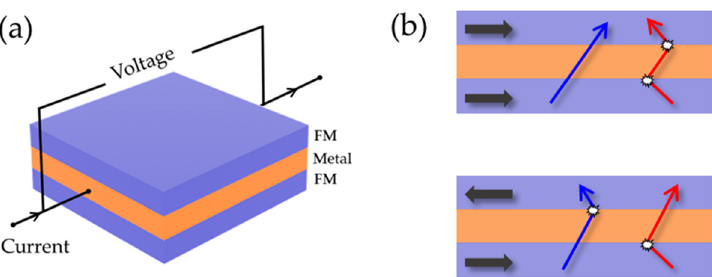
Figure 5. ( a ) Schematic representation of the GMR element, where current is flowing parallel to the film. ( b ) Schematic illustration of the two current models of GMR effect, explaining spin-dependent scattering of parallel magnetization and anti-parallel magnetization at the interface between FM and NM metal layers. Black arrows: the magnetization state of the FM layer. Blue arrows: trajectories of spin-up conduction electron. Red arrow: trajectories of spin-down conduction electron.